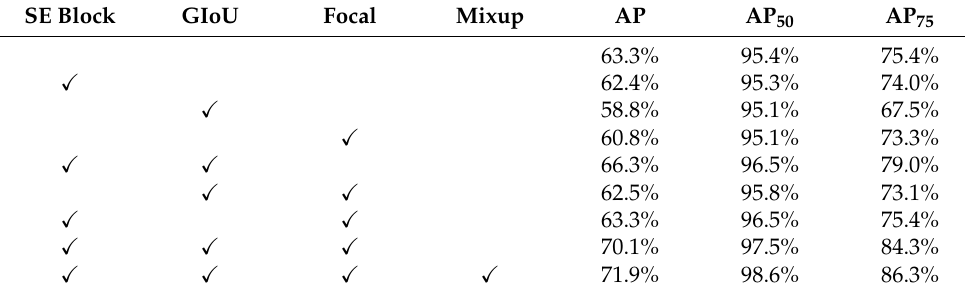
Table 2. Ablation experiment (the input size of the images is 416 × 416). SE